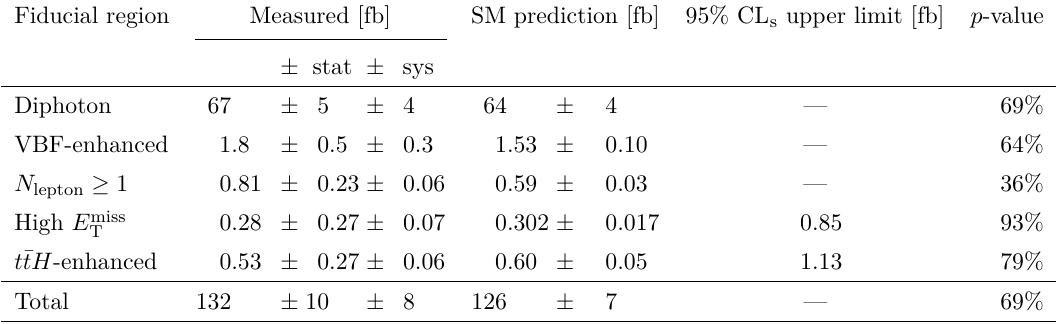
— 69% Table 3. Particle-level cross-sections times branching ratio in the five fiducial regions, together with the total cross-section times branching ratio. The measured values with their statistical and systematic uncertainties are compared with the expected uncertainties and the default SM predictions. Upper-limits at 95% CL are shown for fiducial regions with observed significance below 3 σ . The last column shows the probabilities from a χ 2 compatibility test between the fitted cross-sections and the SM prediction. The χ 2 is computed using the full set of uncertainties in the data and in the